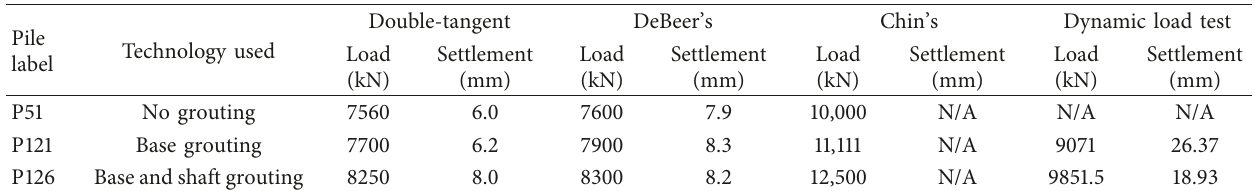
Table 5: Static and dynamic load tests of compressive loaded piles.